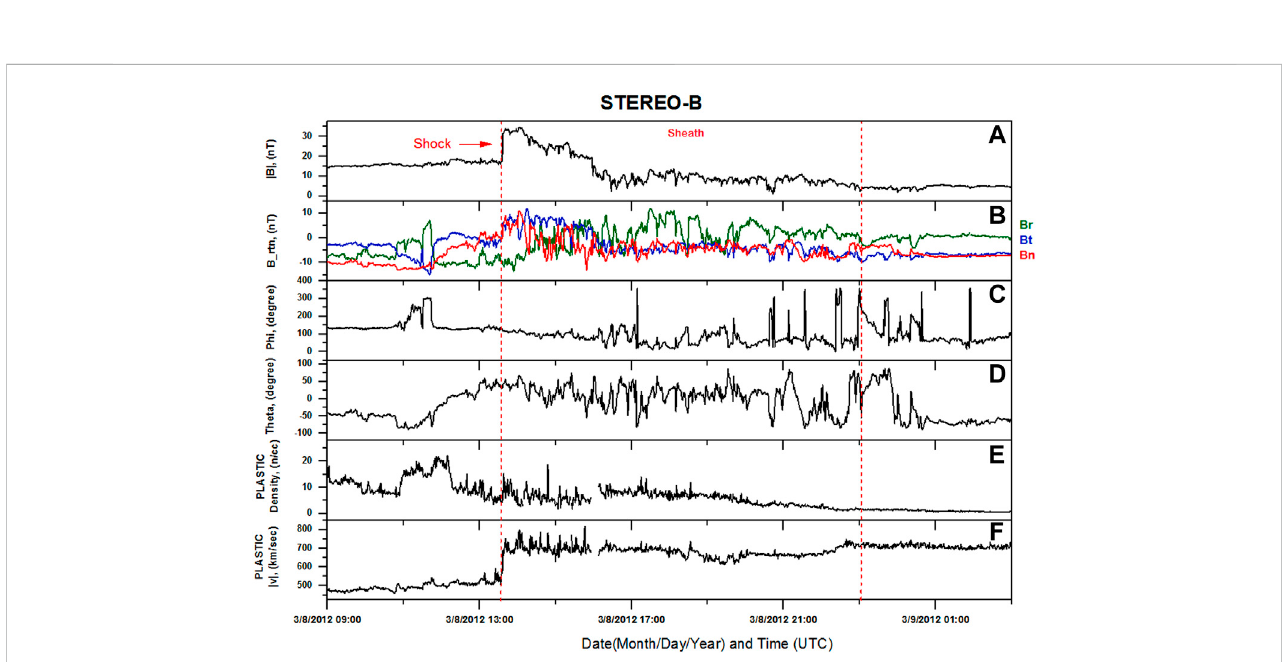
FIGURE 7 ICMEsheathfollowed byshockdetectedbySTEREO-B(withindottedredlines).Fromtoptobottom (A – F) ,thepanelsshowthetotalmagnetic fi eld;x,y, and z components of the magnetic fi eld; phi; theta; density; and velocity, respectively. Theta and phi are the projection angles, as de fi ned in Section